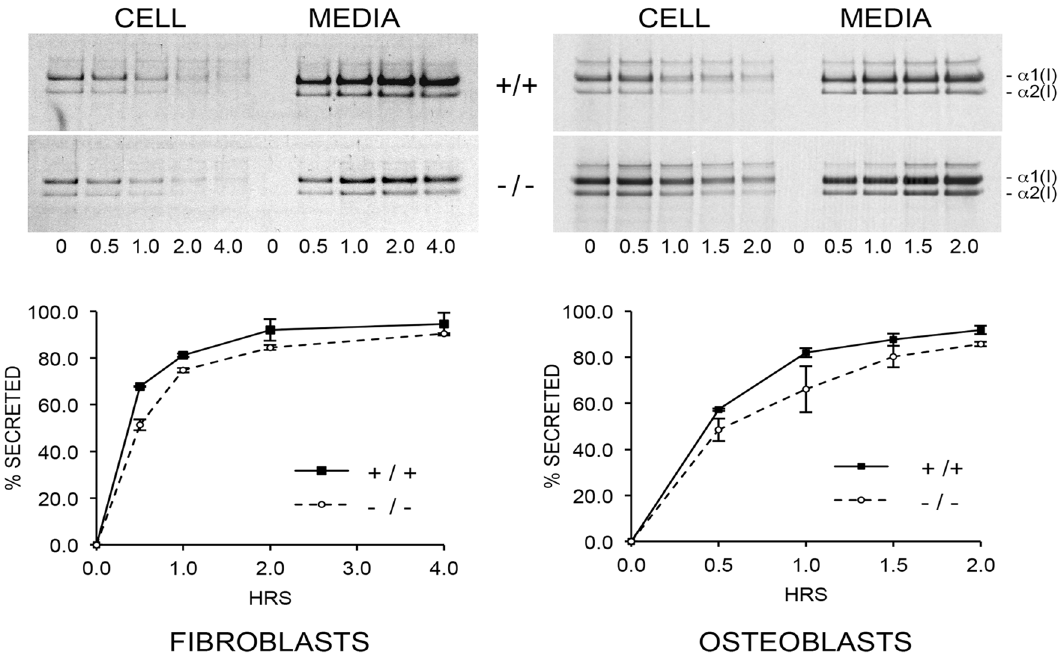
Figure 9. Pulse-chase analysis of type I collagen secretion. There is a minimal delay in secretion of collagen by cyclophilin B-deficient fibroblasts and osteoblasts in culture.